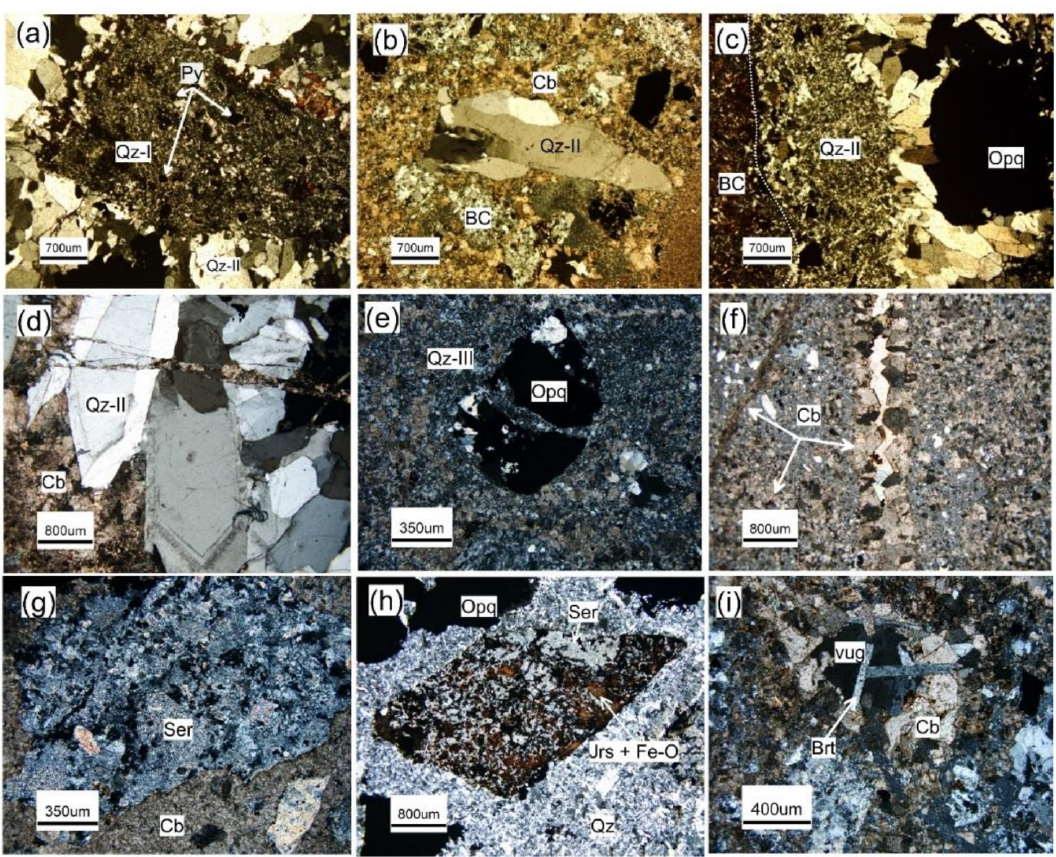
Figure 16. Photomicrographs of gangue minerals from Shah-Ali-Beiglou deposit showing: ( a ) Textural relationships between fine-grained quartz crystals (Qz-I) and coarse-grained crystals (Qz-II) which precipitated during pre-ore stage and ore stage mineralization in breccia zones, respectively; ( b ) Quartz-II in form of breccia clast in breccia-III; ( c ) Quartz-II in form of breccia cement along with ore in breccia-II; ( d ) Quartz-II with zonal texture in quartz-carbonate veins; ( e ) Occurrence of quartz-III within breccia-III; ( f ) Occurrence of carbonate (Cb) as veinlet without ore; ( g ) Occurrence of sericite (Ser) as breccia clast; ( h ) Occurrence of jarosite (Jrs) along with Fe-oxide and sericite within breccia clast; ( i ) Occurrence of barite (Brt) within a